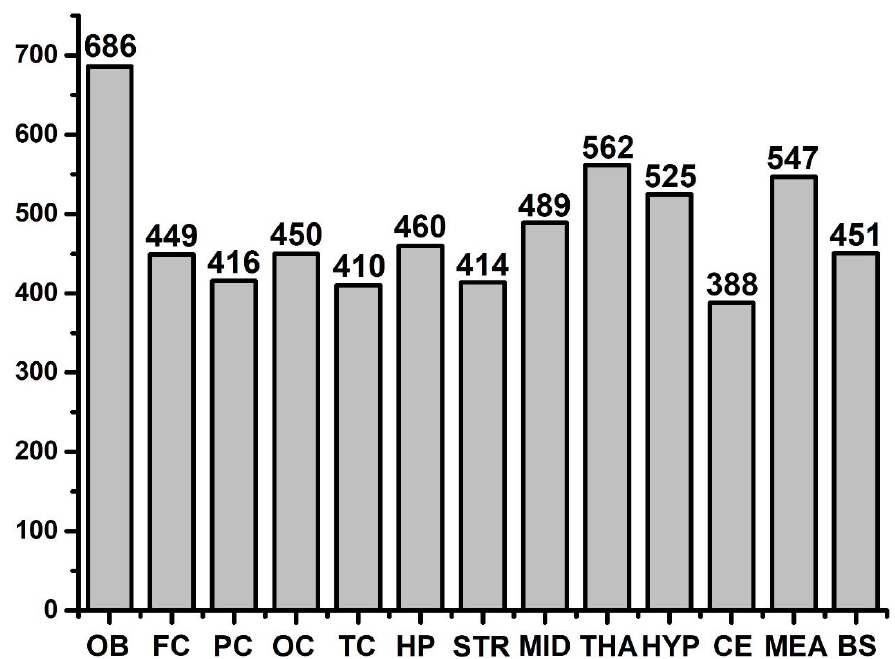
Figure 2. Total species of free fatty acids among different brain regions. Note: OB—olfactory